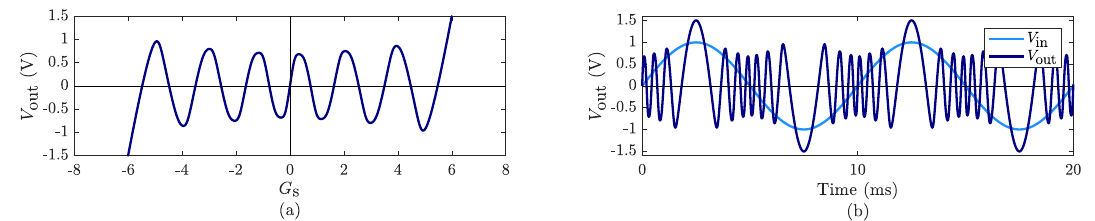
Figure 17. ( a ) Transfer function of the proposed Serge middle VCM; and ( b ) its output when driven by a 100-Hz sinewave for G S = 6 and zero dc offset.